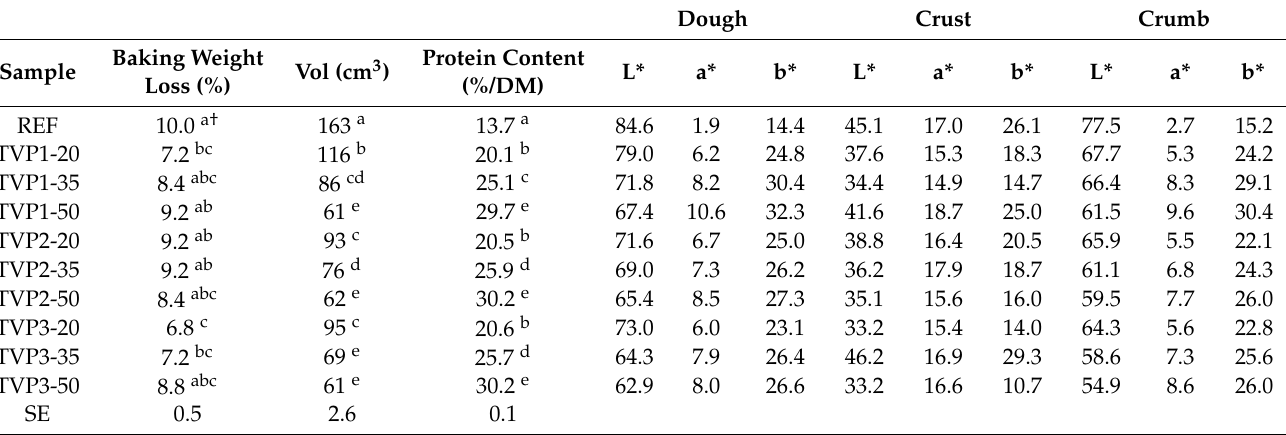
Table 3. Average protein content, baking weight loss, rising ability (Vol) and colour measurements of all sample materials. Average protein content is based on three replicates, while all other measures are based on five